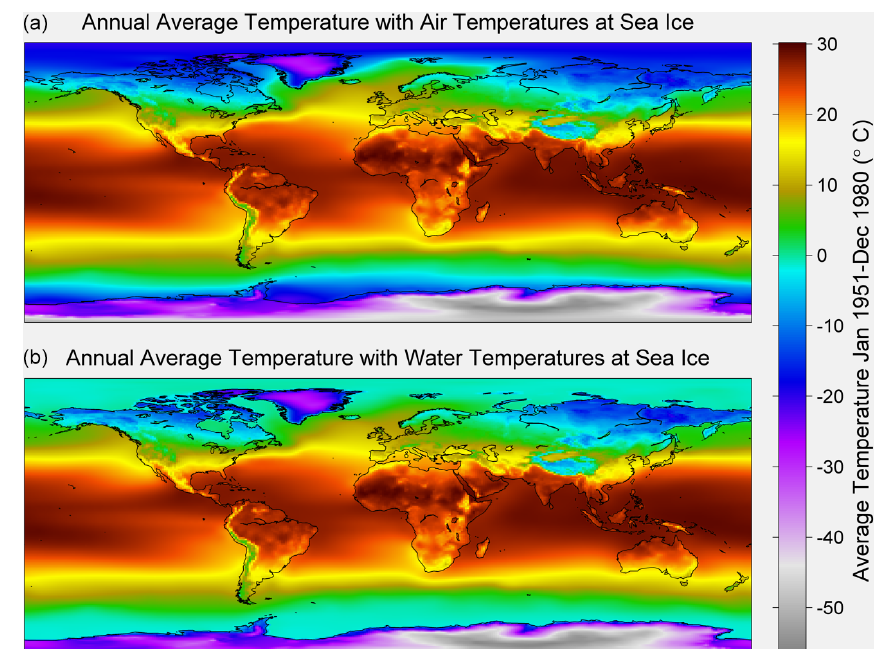
Figure 6. Berkeley Earth average absolute climatology for the period from 1951 to 1980 with the air temperature at sea ice (a) and ocean temperature under sea ice (b) variants shown.